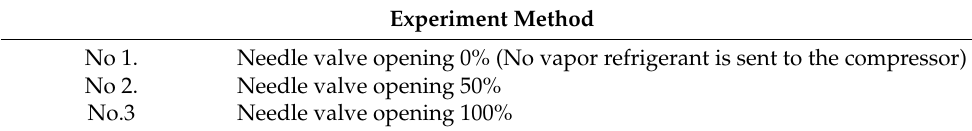
Table 12. Two-evaporator test